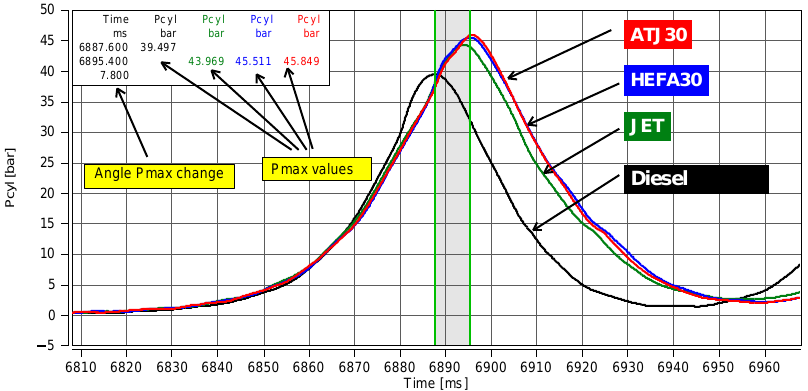
Figure 9. Assessment of the changes in the pressure curves in terms of comparison of the combustion processes.